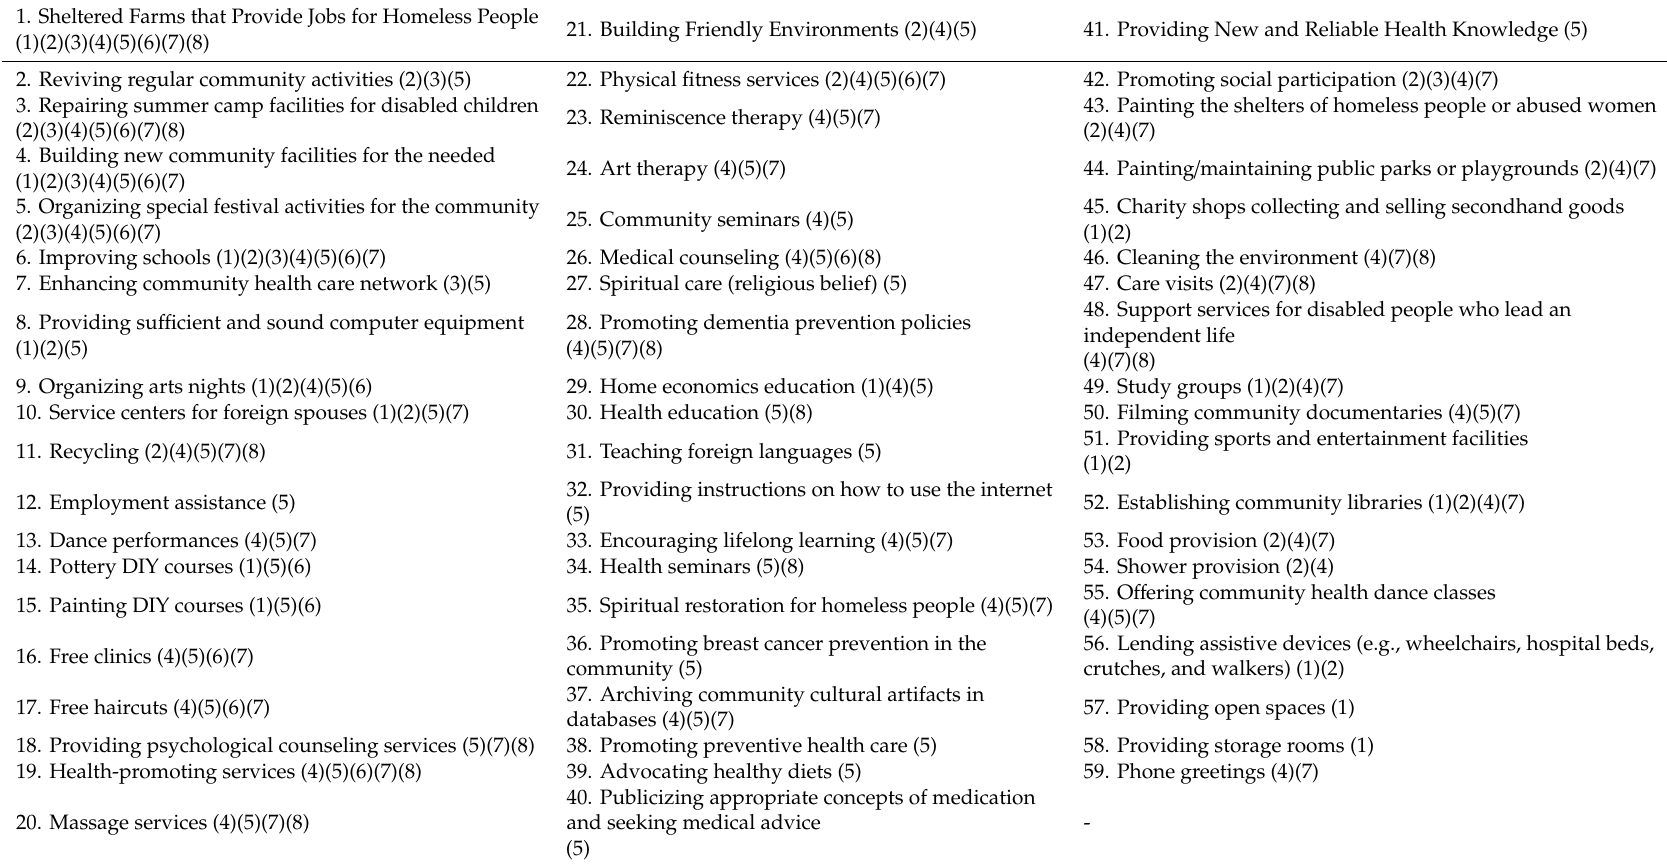
Table 2. Common community health care services in Taiwan and